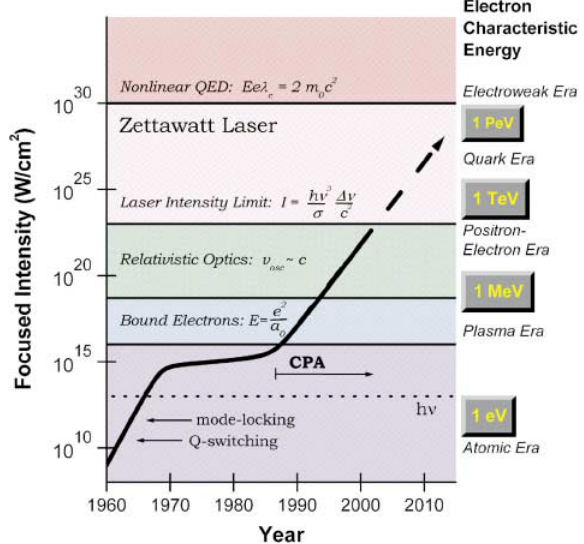
FIG. 1. (Color) Laser-focused intensity vs years for tabletop sys- tems. This system shows the dramatic increase in intensities ex- perienced over the past few years. The figure shows also that the maximum intensity for tabletop systems will be reached in a few years. For the systems we propose, the laser intensity will far exceed these values. 1098-4402 (cid:1) 02 (cid:1) 5(3) (cid:1) 031301(9)$20.00 © 2002 The American Physical Society